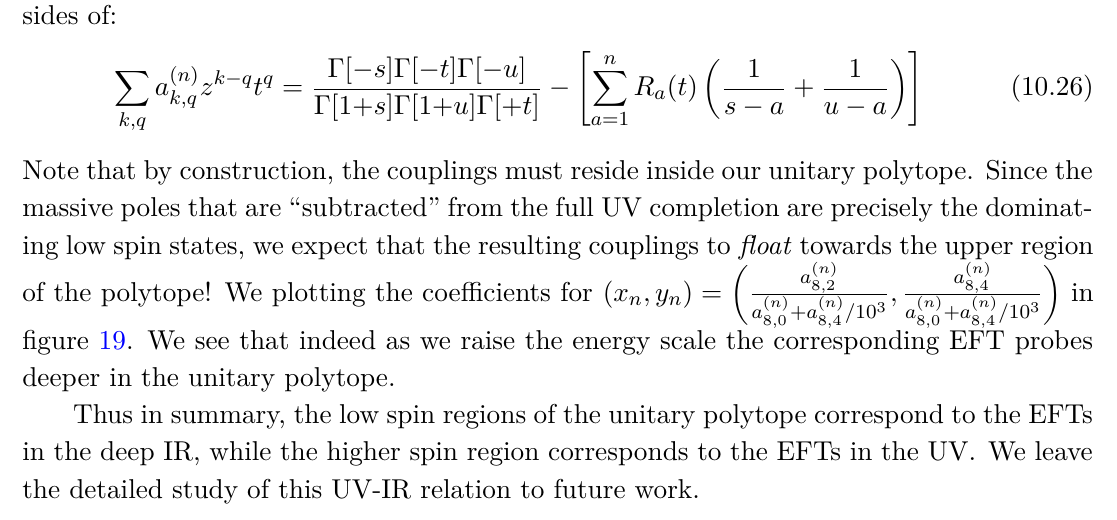
Figure 19 . Oh the l.h.s. we the purple dots indicate ( x n , y n ) for n = 0 , · · · , 20 , representing the position of the type-II string EFT in side the unitary polytope for s ∼ n to large s , the EFT tends to the corner with higher spins. This implies that the UV and IR EFTs populate different regions in the polytope, as illustrated on the